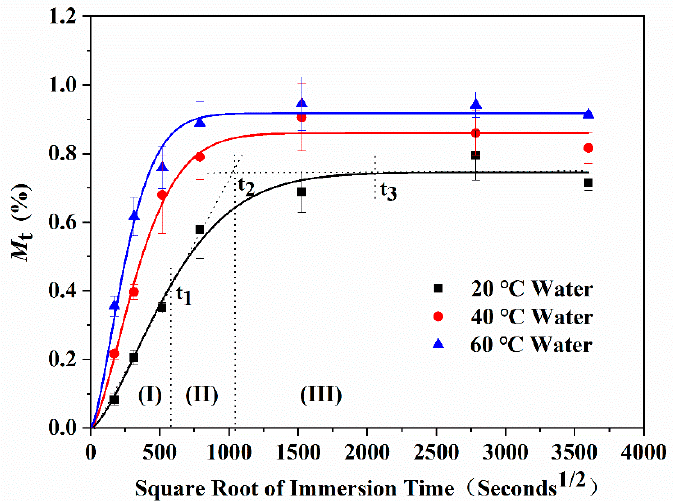
Figure 3. Water uptake curves of the epoxy resin immersed in distilled water at different temperatures. Solid lines represent the fitting curves using Fick’s model.